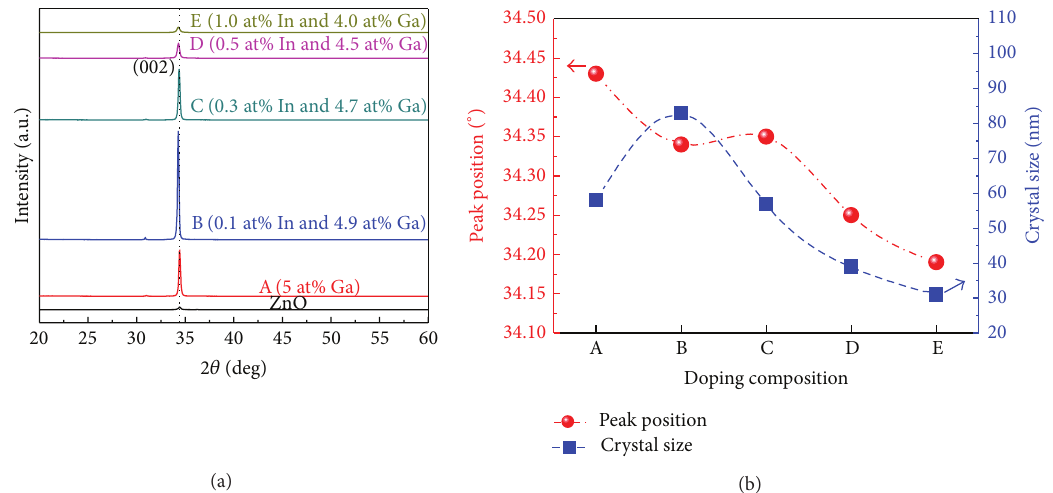
Figure 1: (a) X-ray diffraction patterns and (b) (002) peak position and crystal size of the as-deposited IGZO films with various In and Ga contents in